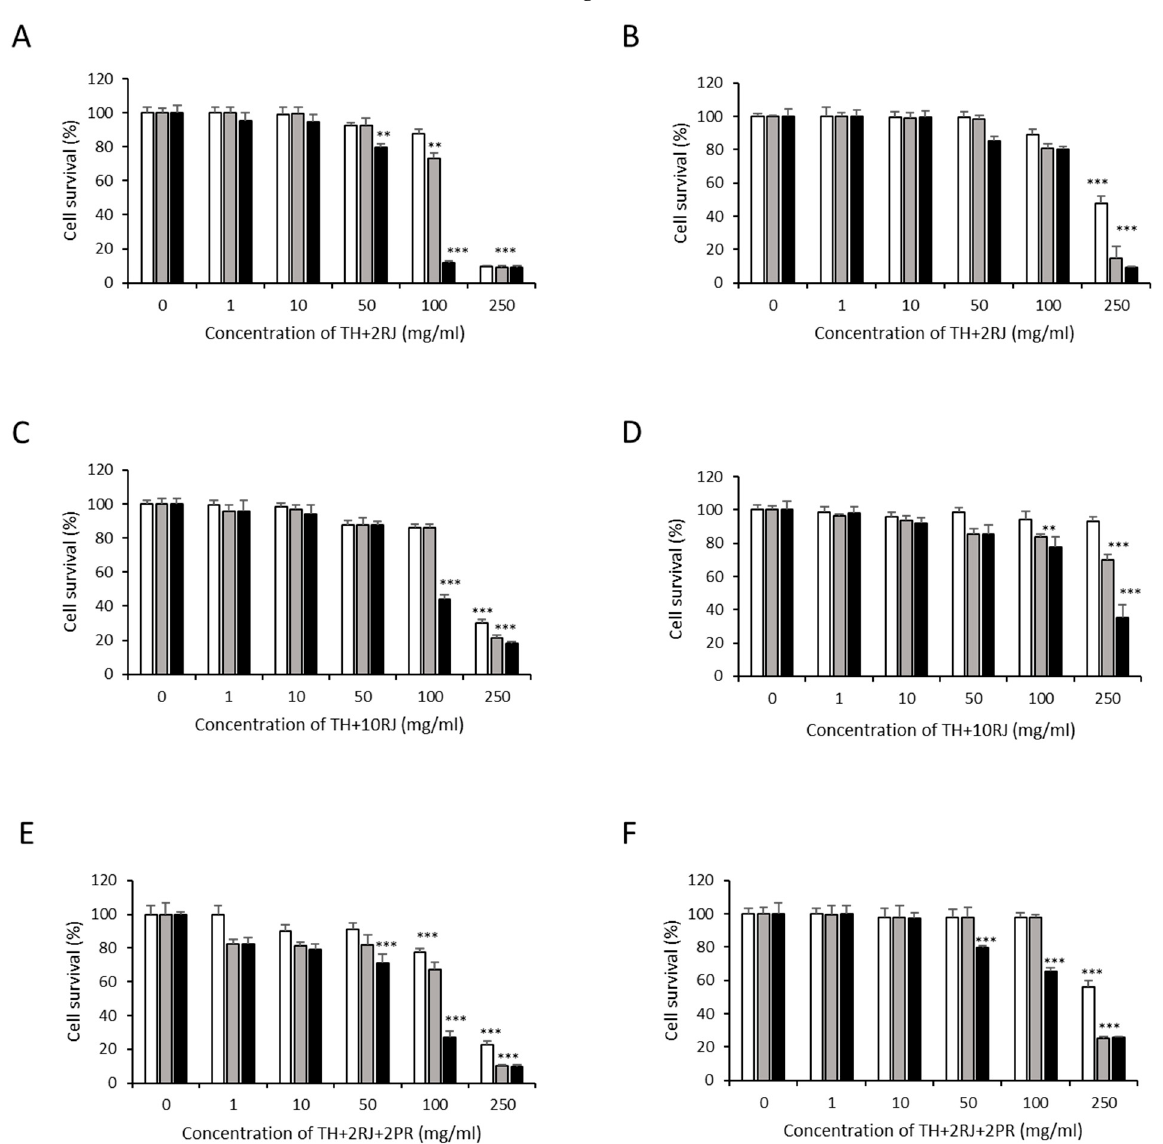
Figure 2. Effects on the viability of HepG2 ( A , C , E ) and WRL-68 ( B , D , F ) cells of sample 2 (TH+2RJ) ( A , B ), sample 3 (TH+10RJ) ( C , D ), and sample 11 (TH+2RJ+2PR) ( E , F ) by MTT assay. Cells were cultured with different doses of samples (0–250 mg/mL) for 24 ( □ ), 48 ( ■ ), and 72 h ( ■ ). Asterisks indicate a significant difference from the control (0). ** p ≤ 0.01, *** p ≤ 0.001. Focusing on CH mixtures (Figure 3), samples 7 (CH+2RJ) and 8 (CH+10RJ) started to show a significant cytotoxic effect ( p < 0.05) on HepG2 cells at 100 mg/mL (Figure 3A,C) that was not observed for WRL-68 cells (Figure 3B,D). These samples only produced cytotoxic effects on WRL-68 cells at 250 mg/mL and for all times tested. Sample 9 (CH+2PR)